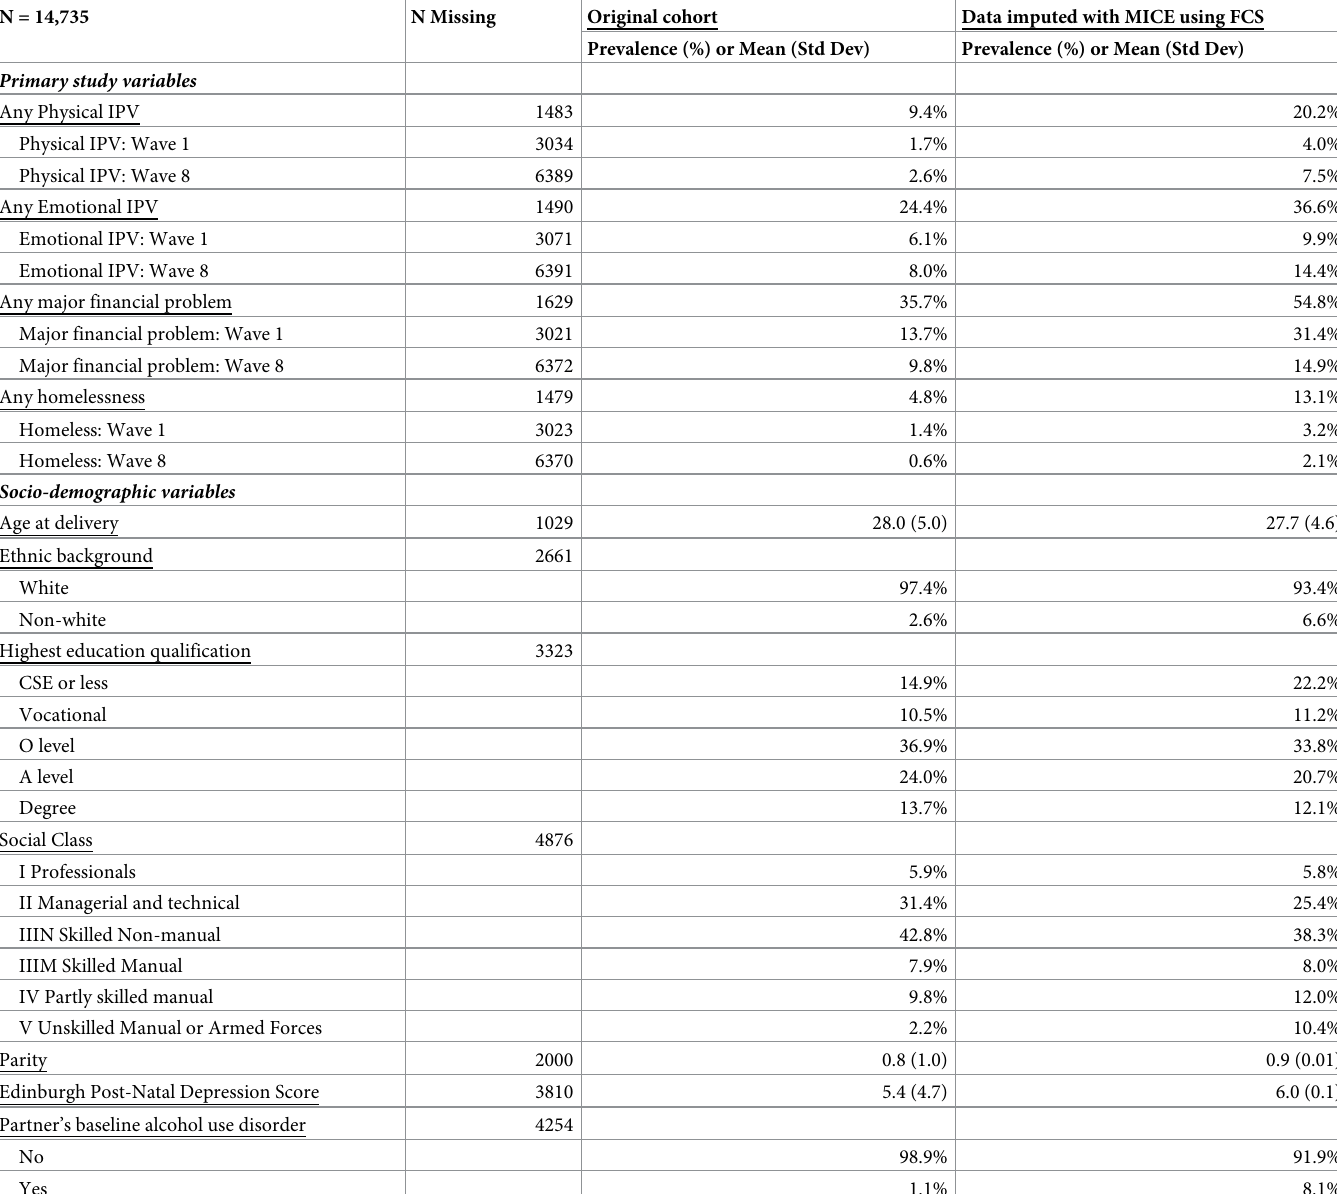
Table 1. Characteristics of study population (First and last wave measurements are listed for time-varying variables). N =